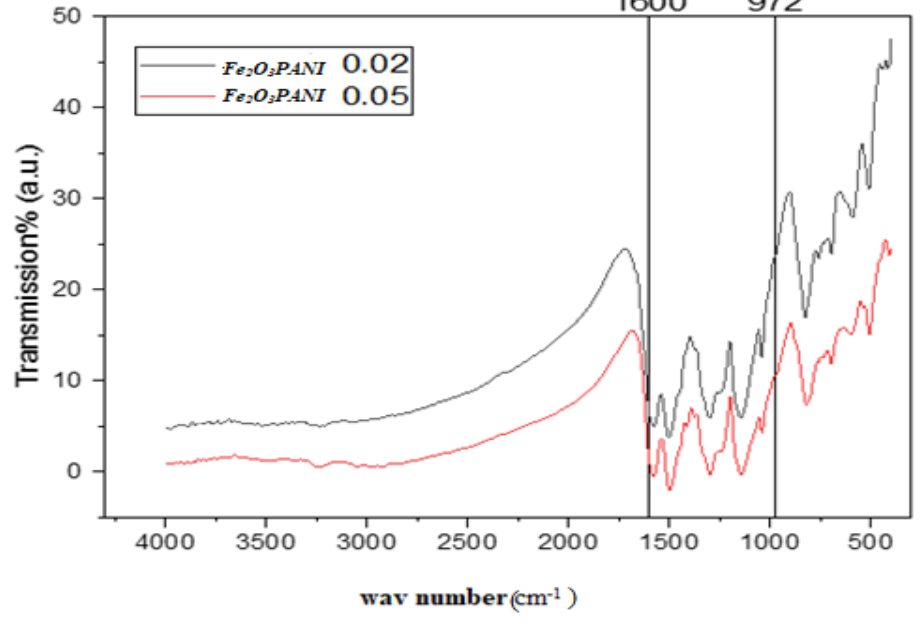
Figure 1: The Fe